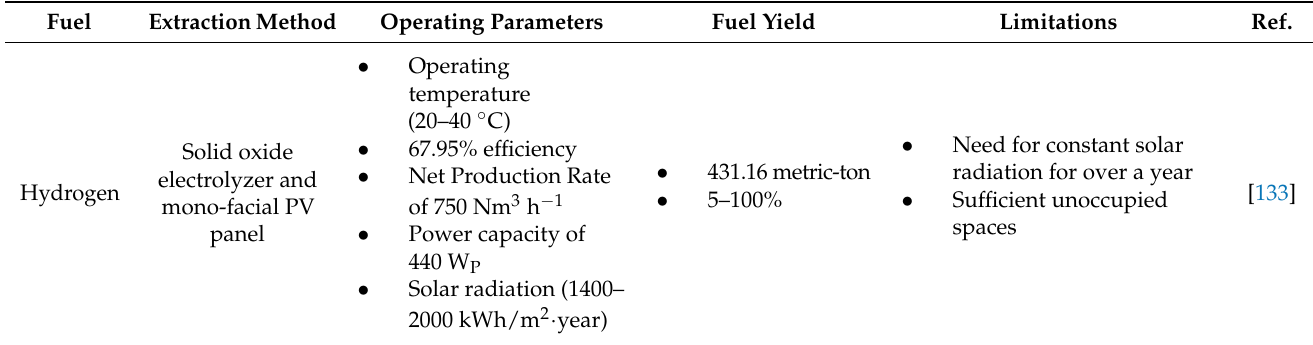
Table 2. Summary of the sustainable fuel yield with extraction method and operating parameters. Fuel Yield Limitations